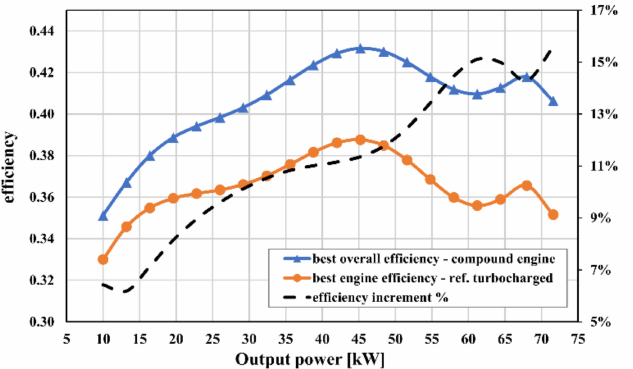
Figure 20. Comparison between the best efficiency curves of the compound engine with respect to the reference turbocharged engine ( T 4 /T 1 = 4.5 and η T =